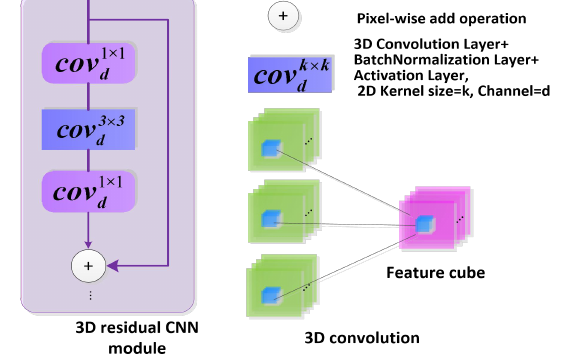
Figure 3 . 3D residual convolution block.